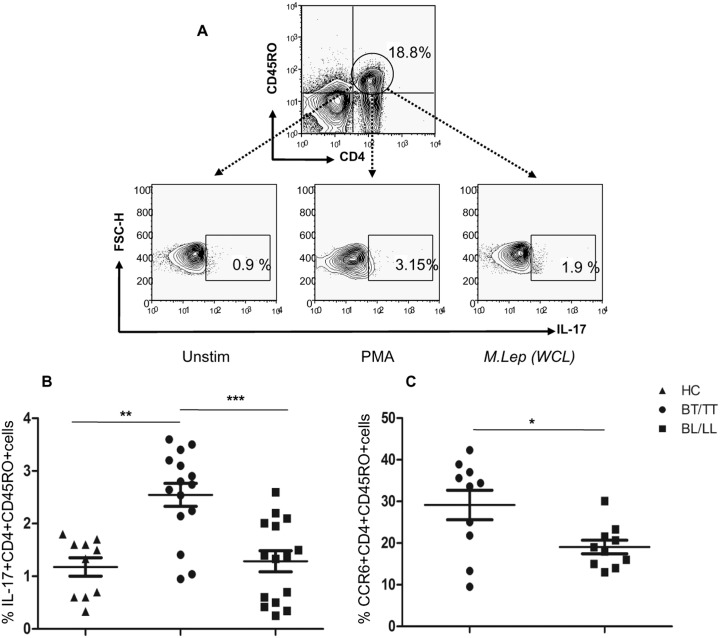
Identification of Th17 cells in Leprosy.A) Representative flow cytometric analysis showing IL-17 production on gated CD4+ CD45RO+ memory T cells following in vitro stimulation with M. leprae (WCL) vs. unstimulated for 48 h in a Leprosy patient with BT. 6 h PMA stimulation was used as positive control. B) Scatter plots are showing cumulative IL-17 production in gated CD4+ CD45RO+ cells in different groups of Leprosy patients (BT/TT vs. BL/LL) and Healthy Contacts (n = 10). Each dot represents a single individual of BT/TT (n = 15) and BL/LL (n = 15) patient. C) Scatter graphs are showing CCR6 surface expression on gated CD4+CD45RO+ cells in different groups of Leprosy patients (BT/TT vs. BL/LL) (n = 10). Median values are shown in each set while P value< 0.05 was considered to be significant. Total number of cells analyzed by flow cytometry were 500,000. Data analysis was performed with flowjo software. Statistical analysis was done using Student’s t test for unpaired samples.